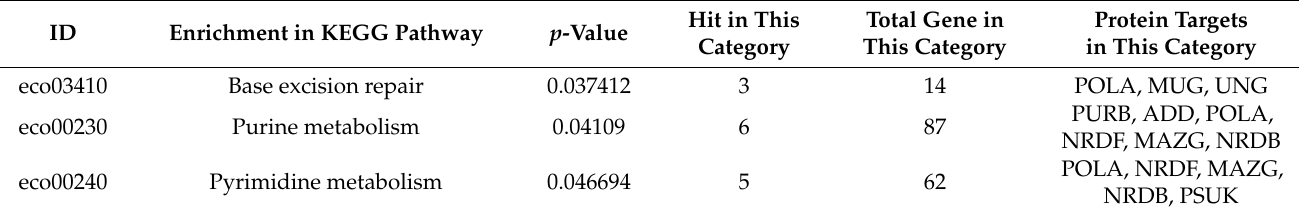
Table 5. Enrichment categories in Kyoto Encyclopedia of Genes and Genomes (KEGG) pathways for the protein targets of